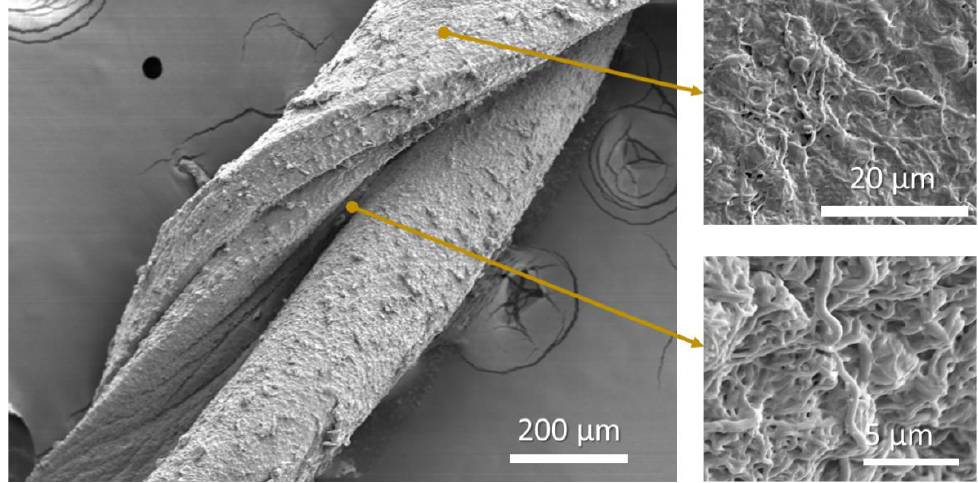
Figure 4. SEM micrographs of PANI yarn after 2 min HCl vapour treatment, with magnification of the outside layer (top right) and inside layer (bottom right).